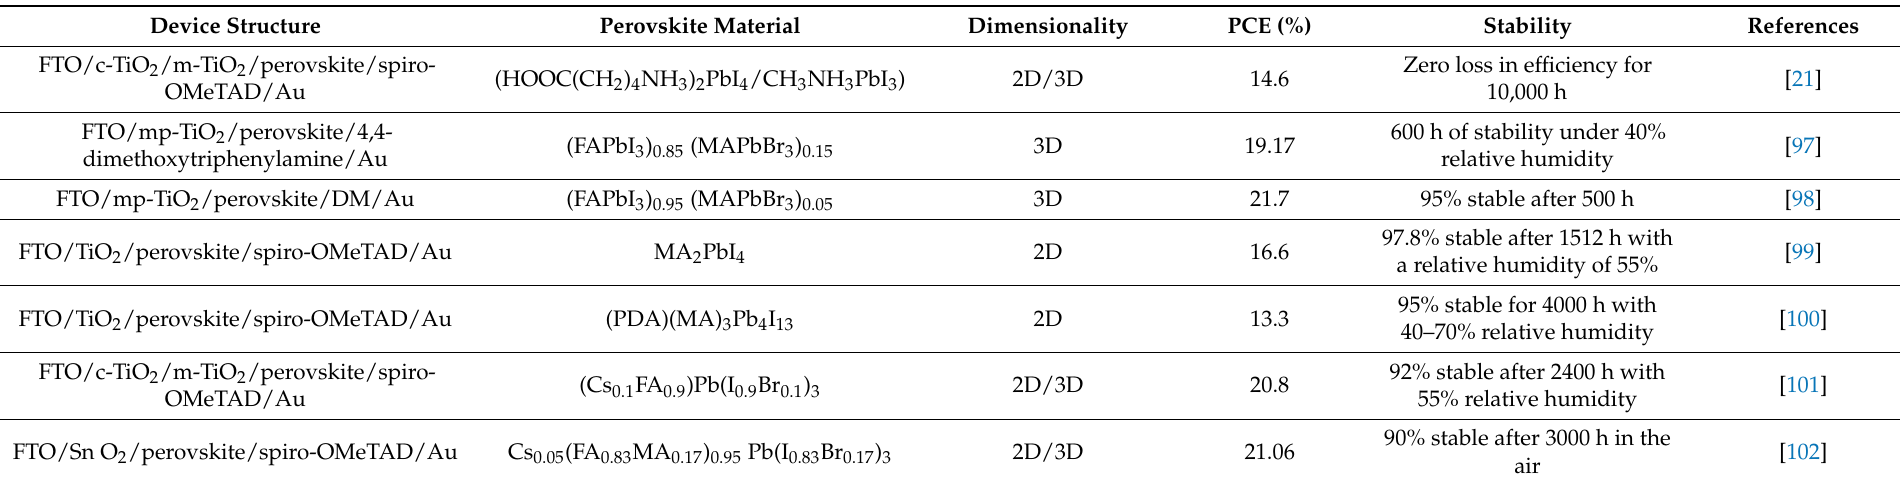
Table 4. Advancements in the stability of